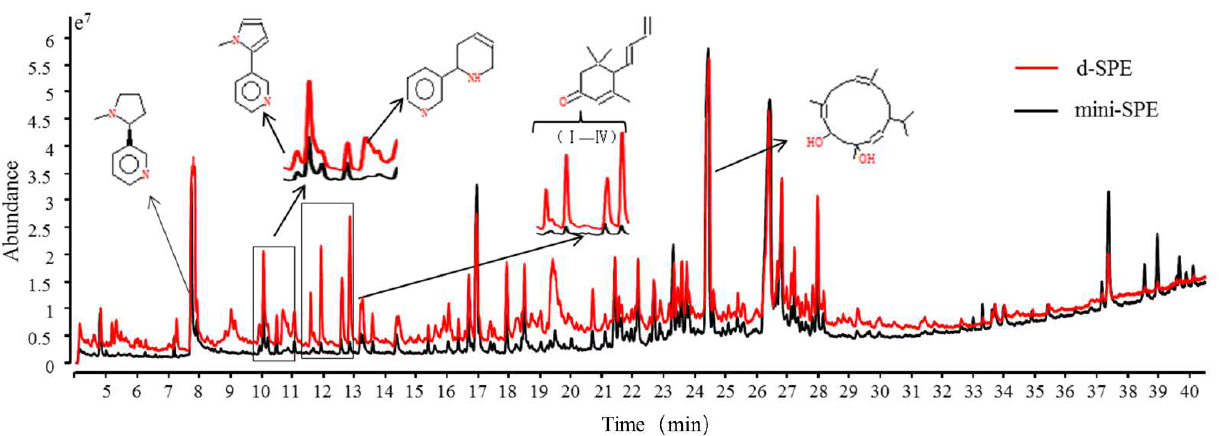
Figure 7. Total ion current (TIC) chromatogram of blank tobacco extract extracted with mini-SPE (black) and with d-SPE (red) method.